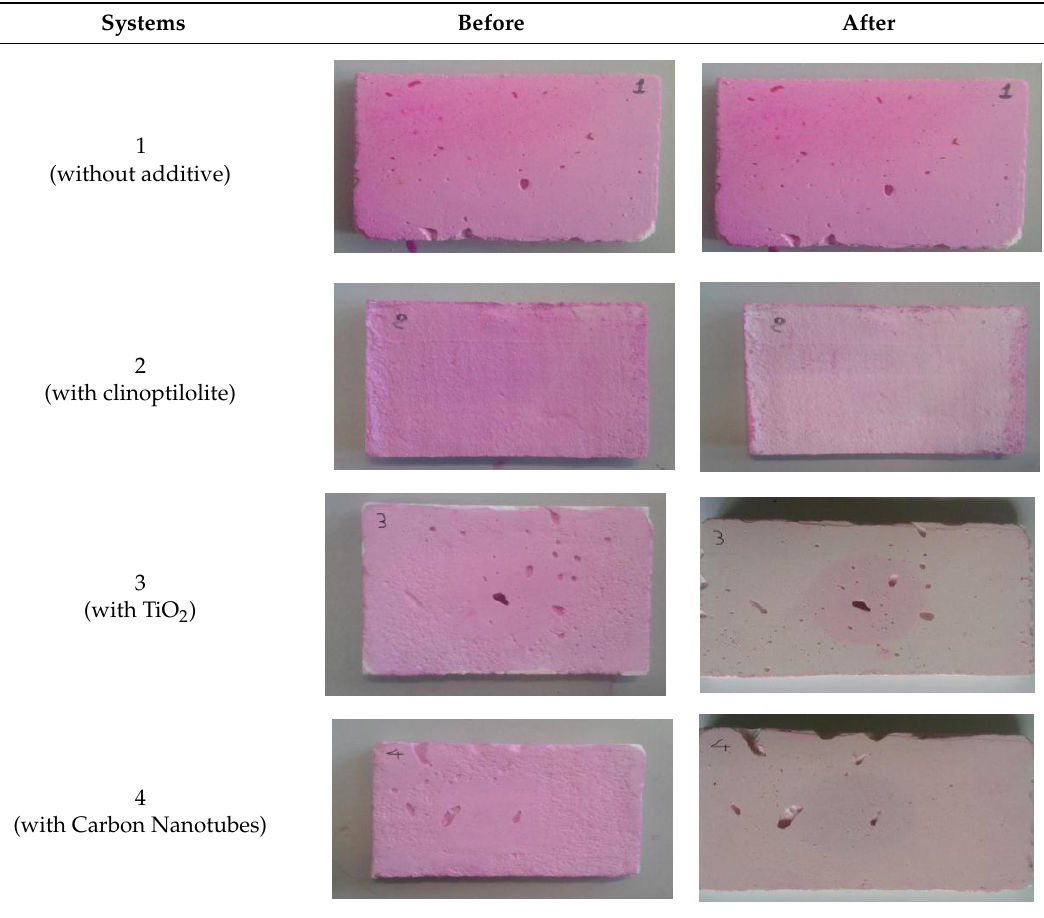
Table 2. Images of specimens before and after UV irradiation for 3 h.